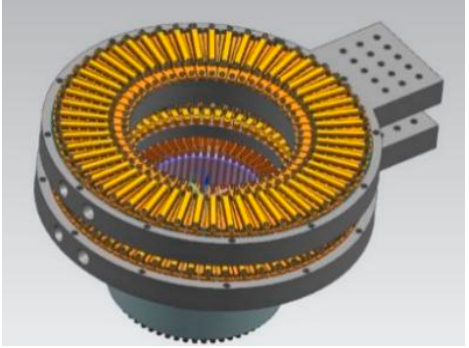
Figure 1. Design model of 5V/1000A permanent magnet synchronous generator integrated DC output system (PMSG-IDOS).